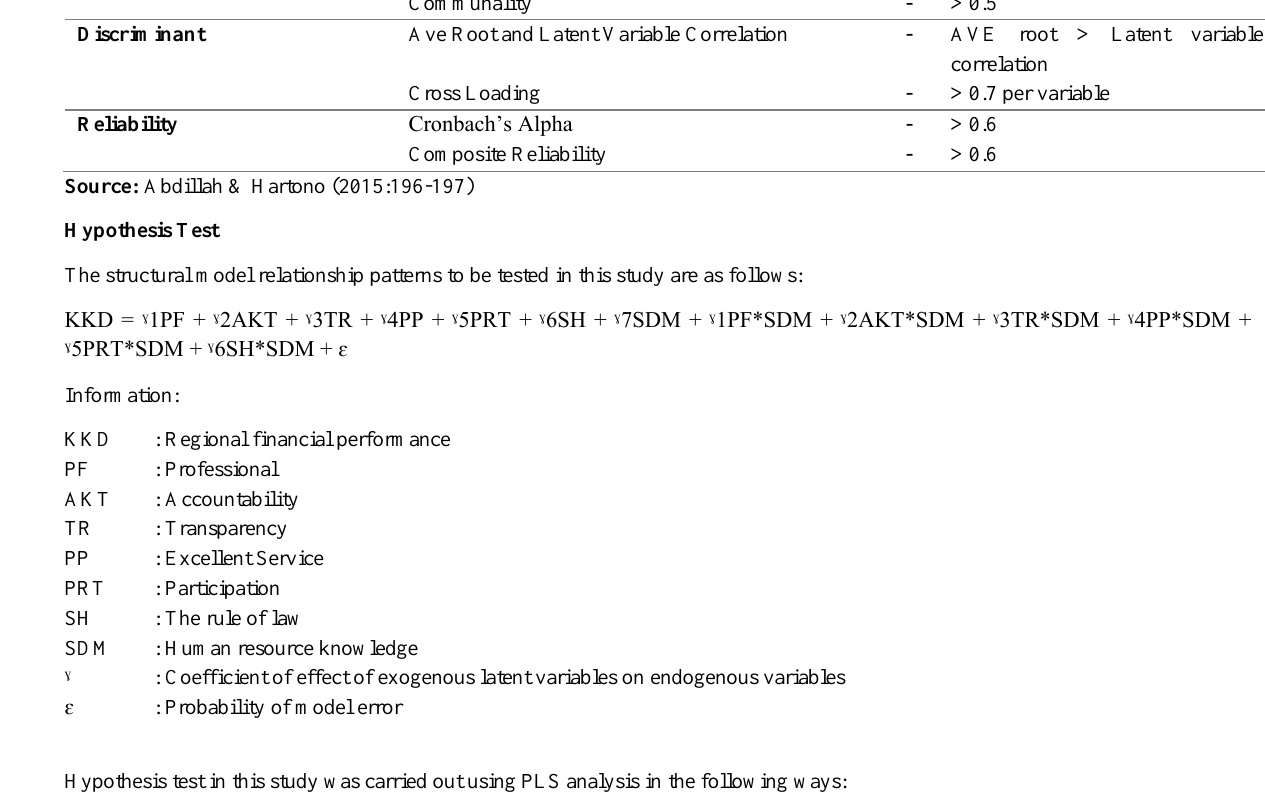
- > 0.5 - > 0.7 - > 0.5 - AVE root > Latent variable correlation - > 0.7 per variable - > 0.6 - > 0.6